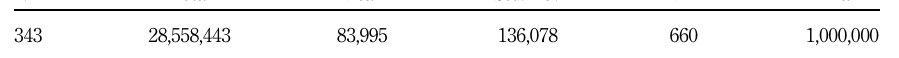
Panel B: Timing of the bonus issue announcements Year of the announcement